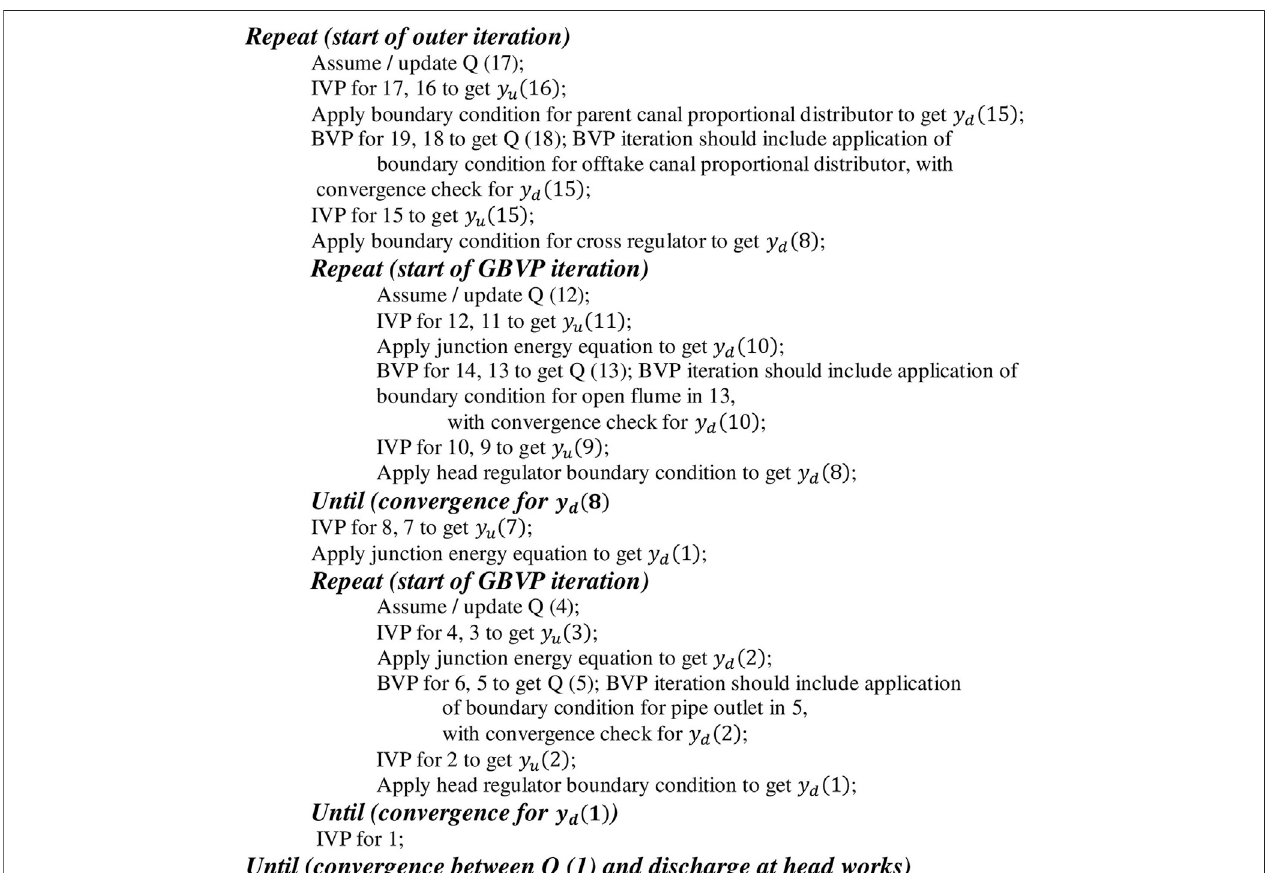
FIGURE 3 | Pseudo code for computational algorithm for example